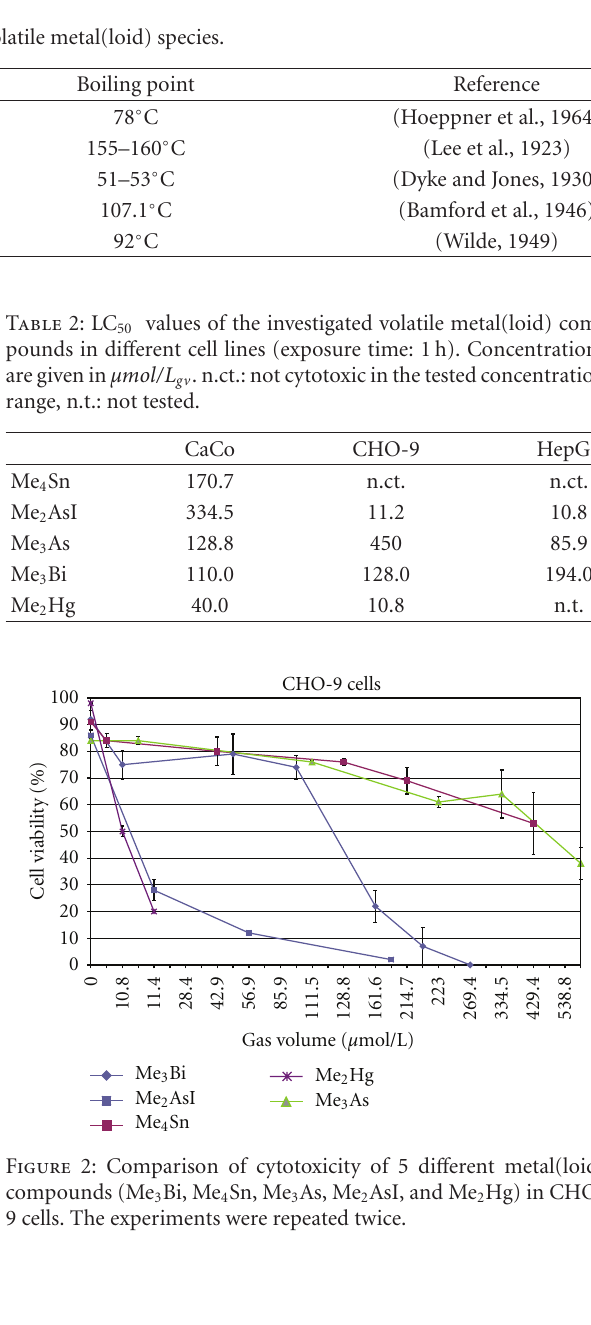
cytotoxic and induced 50% cell death (LC 50 ) in CHO-9 cells already at the lowest concentration tested (10.8 µ mol / L gv